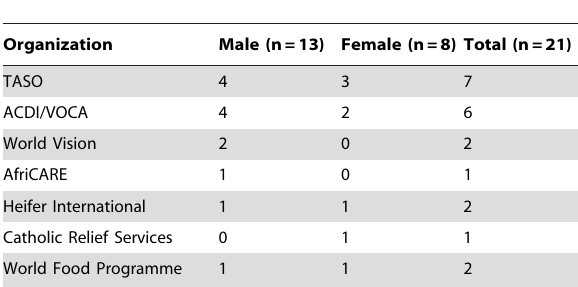
Table 1. Key informants by gender and organization.